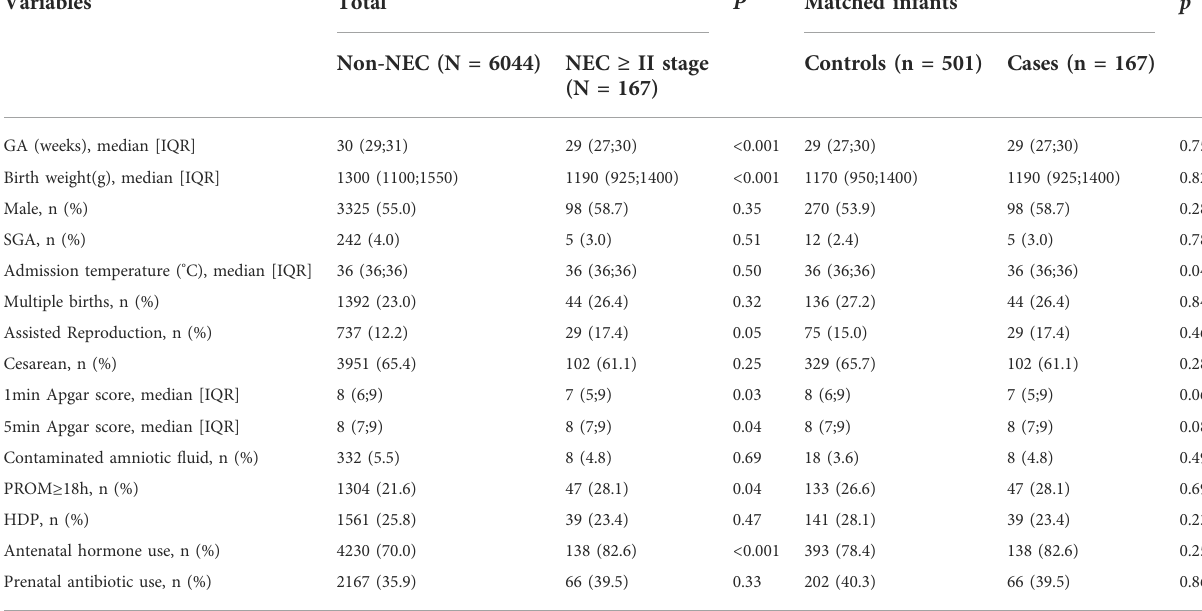
TABLE 1 Comparison of general data and perinatal factors before and after